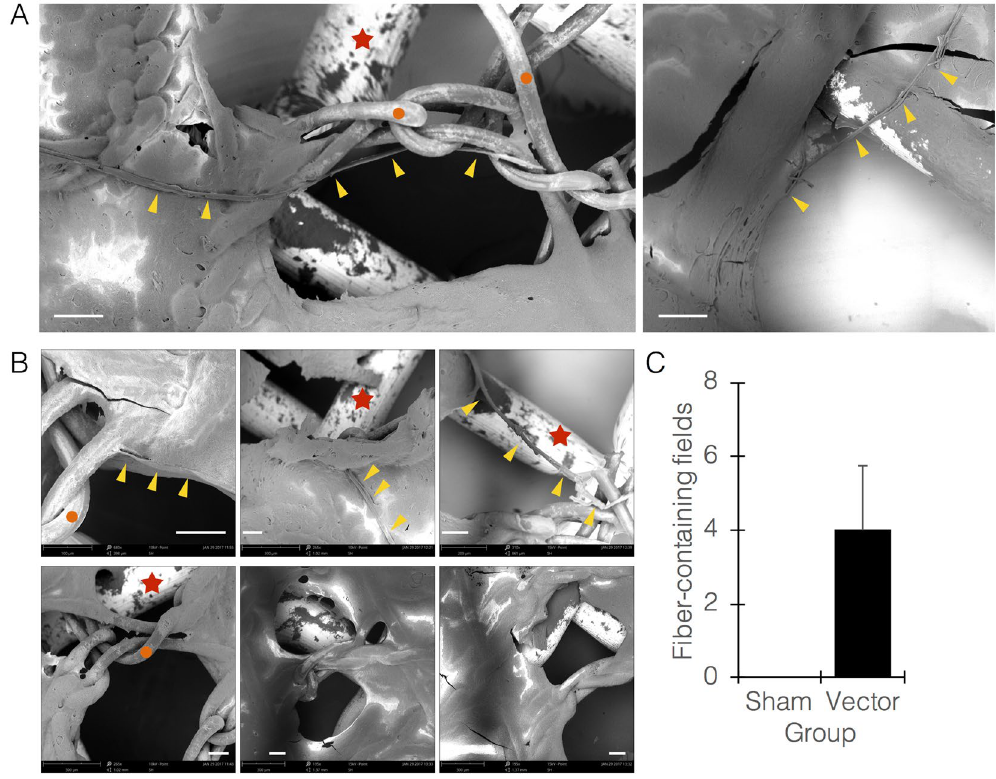
Figure 4. Regenerating fabric system. ( A ) Representative SEM images of regenerating fabric at t = ~15 minutes following tear of fabric-biofilm hybrid. Yellow arrowheads point at newly-made and assembled silk fibers. Red stars point at metal net discs used for imaging. Orange circles point at fabric fibers. ( B ) images of torn regenerating hybrids (top 3 panels) vs. torn hybrids made with wildtype biofilms (bottom 3 panels), the latter showing no newly-made fibers. All images were taken at tear region. ( C ) Quantitation of imaging fields visualized by light microscopy (sham, wildtype biofilms; vector, engineered biofilms). All size bars = 100 μ